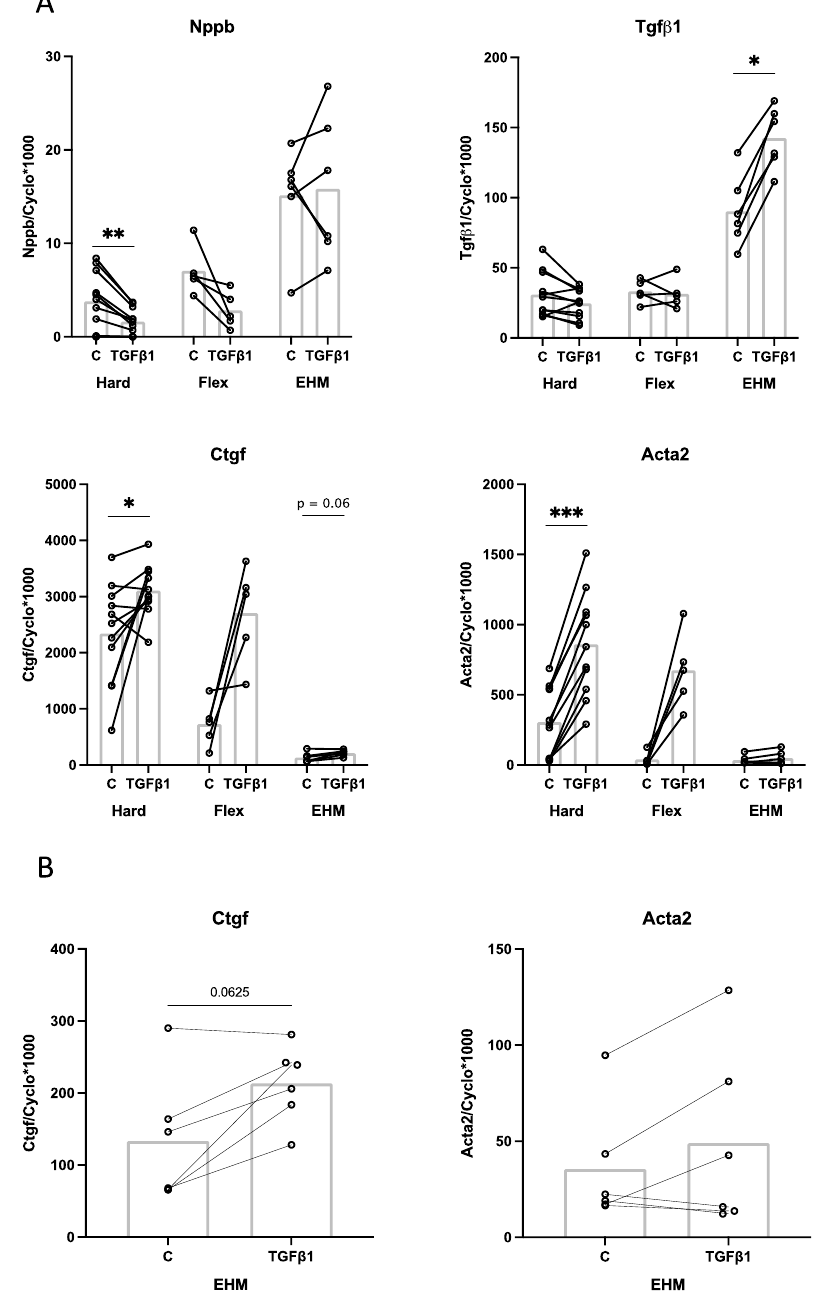
Figure 8. The effect of TGF β 1 stimulation of rat CF for 24 h cultured on different substrates. Presented are the relative gene expression levels of Nppb, Tgf β 1, Ctgf and Acta2 after stimulation with TGF β 1 (TGF β 1) or control (C) conditions for 24 h in 2D hard plastic cell culture plates (Hard, n = 11), 2D Bioflex plates (Flex, n = 5) and 3D EHM (EHM, n = 6) ( A ); Graphs of the relative gene expression levels of Ctgf and Acta2 in EHM were enhanced to improve readability ( B ). * p < 0.05; ** p < 0.01; *** p < 0.001. Bar indicates mean.